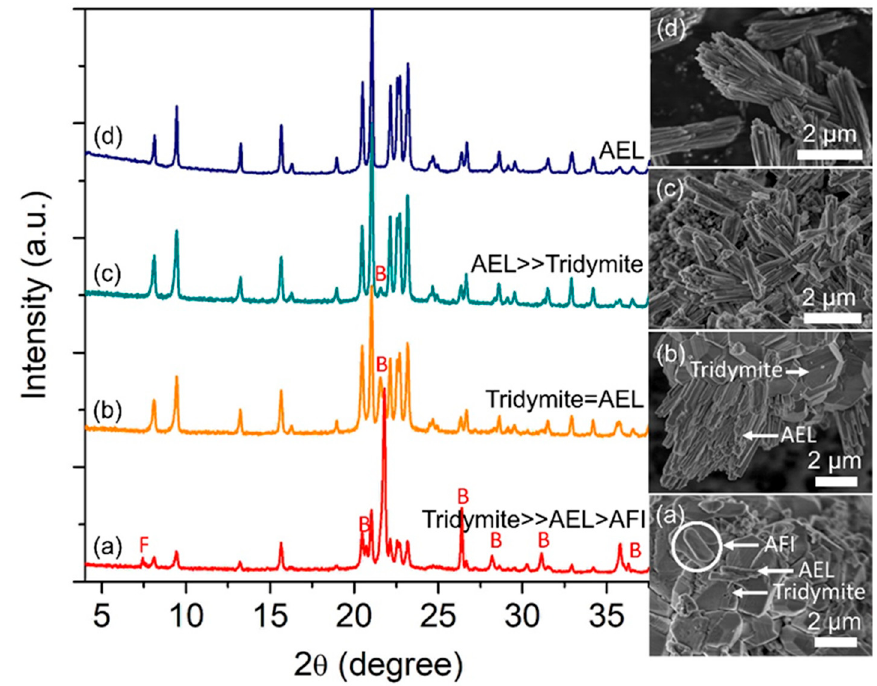
Figure 5. XRD patterns and FESEM micrographs of ( a ) E-14 ( z = 14), ( b ) E-15 ( z = 22), ( c ) E-16 ( z = 30) and ( d ) E-3 ( z = 38) samples. The samples were prepared using the ionogel of 1.0Al: 1.8P: 0.3Si: z [PPy]Br heated at 150 °C for 133 h. F and B denote the presence of AFI and berlinite crystalline phases, respectively.